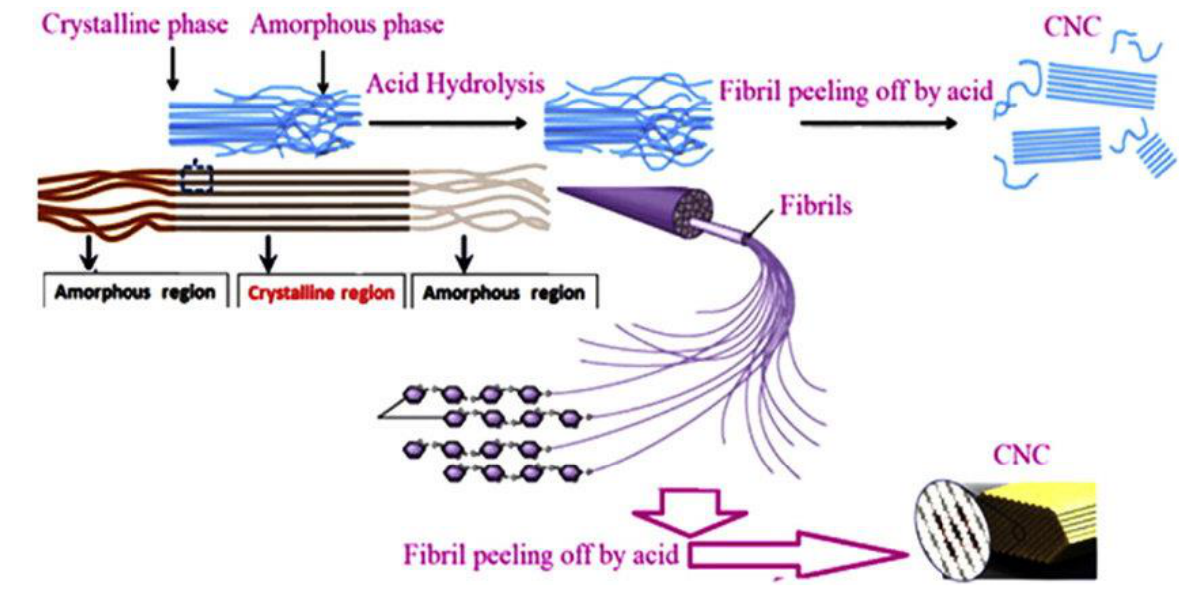
Figure 2. Extraction of cellulose nanocrystals. (Copyright and permission, Elsevier — 2022).